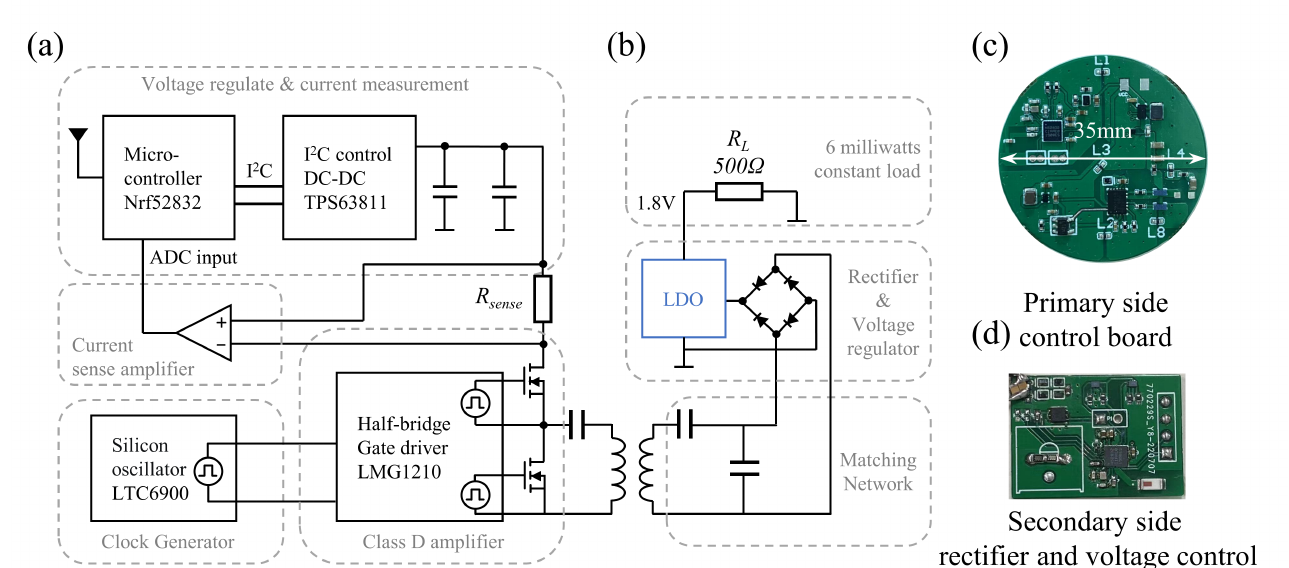
Figure 6. Miniaturized linear-power-regulated wireless power transfer system. ( a ) Schematic of the miniaturized primary side power control system, ( b ) schematic of the LDO-based secondary side wireless power receiver system, ( c ) photograph of the miniaturized primary side power control board, ( d ) photograph of the secondary side wireless power receiver board.